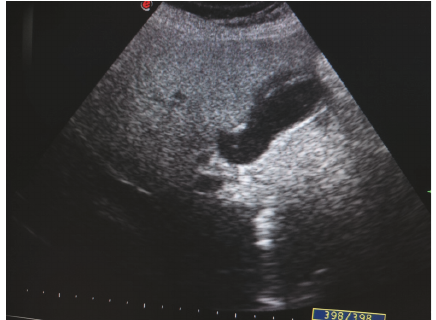
Figure 3: The echogenic debris in the